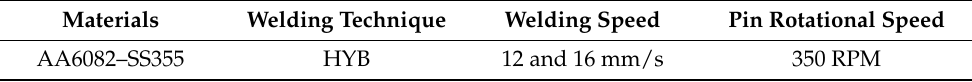
Figure 5. Flowchart showing the steps involved in calculating the net power input using the heat generation model and the subsequent Finite Element and analytical/numerical analysis for each corresponding welding condition.